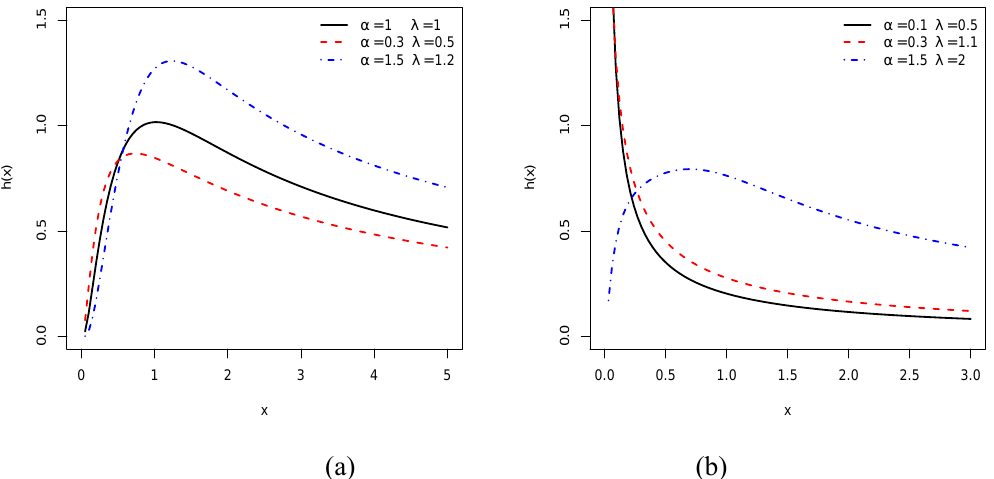
Figure 2 - Plots of the LONPC hazard rate for some values of λ and α